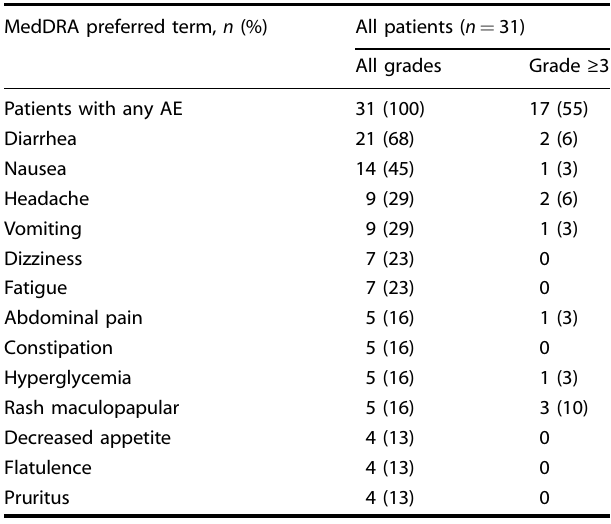
Table 3. AEs occurring in >10% of treated patients irrespective of